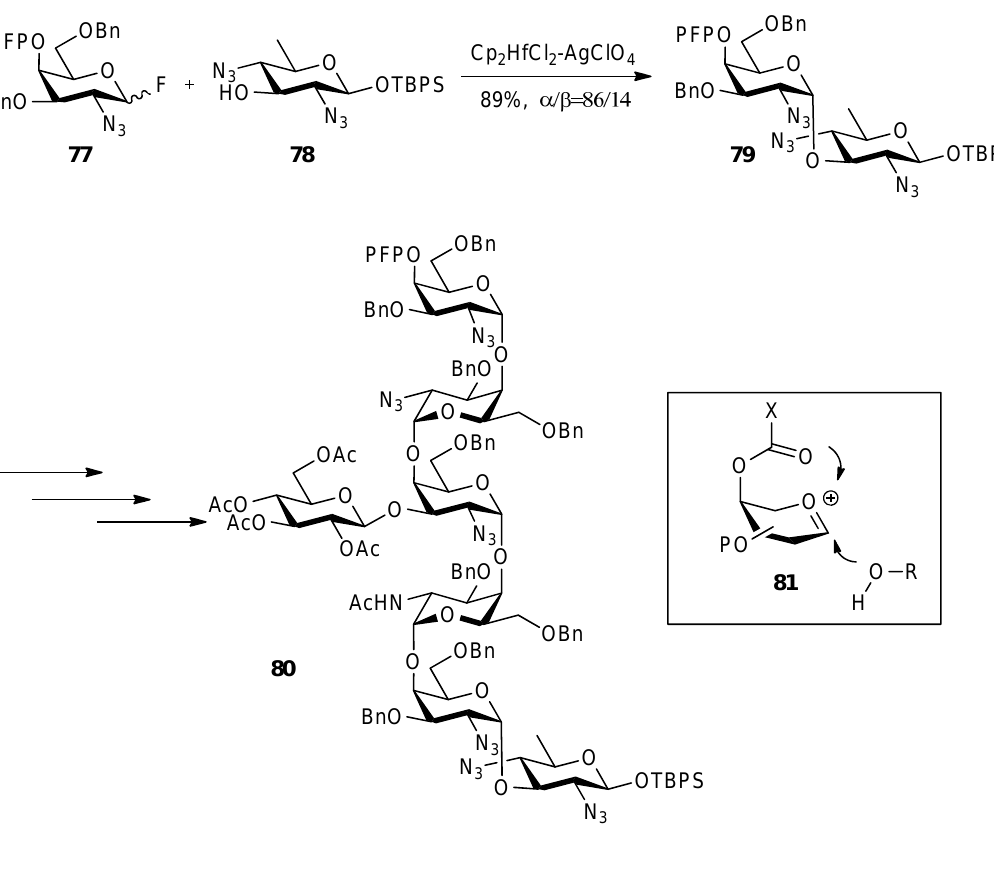
Scheme 13. Synthesis of a heptasaccharide from Gram-negative